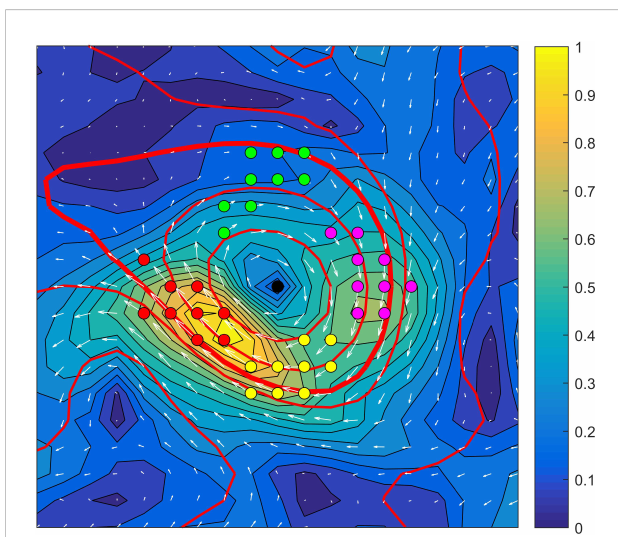
FIGURE 2 Four kinds of assimilation strategies. The colored bold points denote the (synthetic) observations and the red, green, purple, and yellow dots correspond to the (synthetic) observations assimilated by PF1, PF2, PF3, and PF4, respectively. The PF1 assimilates nine observations in the sensitive area, while the PF2, PF3, and PF4 assimilate nine observations in the non- sensitive area obtained by rotating 90°, 180°, and 270° along the vortex rotation direction starting from the PF1 assimilation area, respectively. Note that the distribution of the nine observations in each area shows an example of randomly selected 10 groups of observational